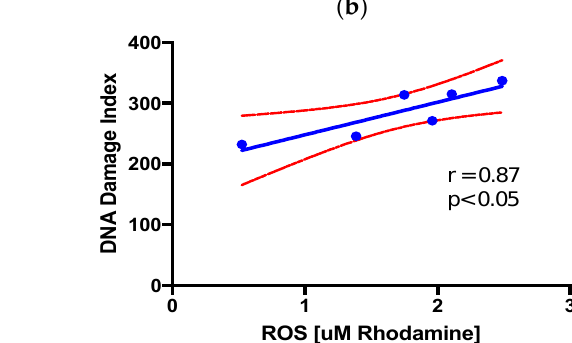
Figure 2. TNFα non affects cell viability and induces DNA damage. ( a ) Cell viability of adipocytes and adipocytes treated by 24 h with TNFα 125 ng/mL, three independent experiments were carried out. Student t test p > 0.05 non-significant. ( b ) DNA damage images representatives of comet assay, acquired with Komet V5.0 . ( c ) Percentage distribution of DNA dam- age categories (Cat 0 less damage to Cat IV higher damage), in adipocytes and adipocytes treated with TNFα; three inde- pendent experiments were carried out. Two-way ANOVA test * p < 0.05. ( d ) DNA damage-index differences induced by TNFα treatment, Student’s t test * p < 0.05.